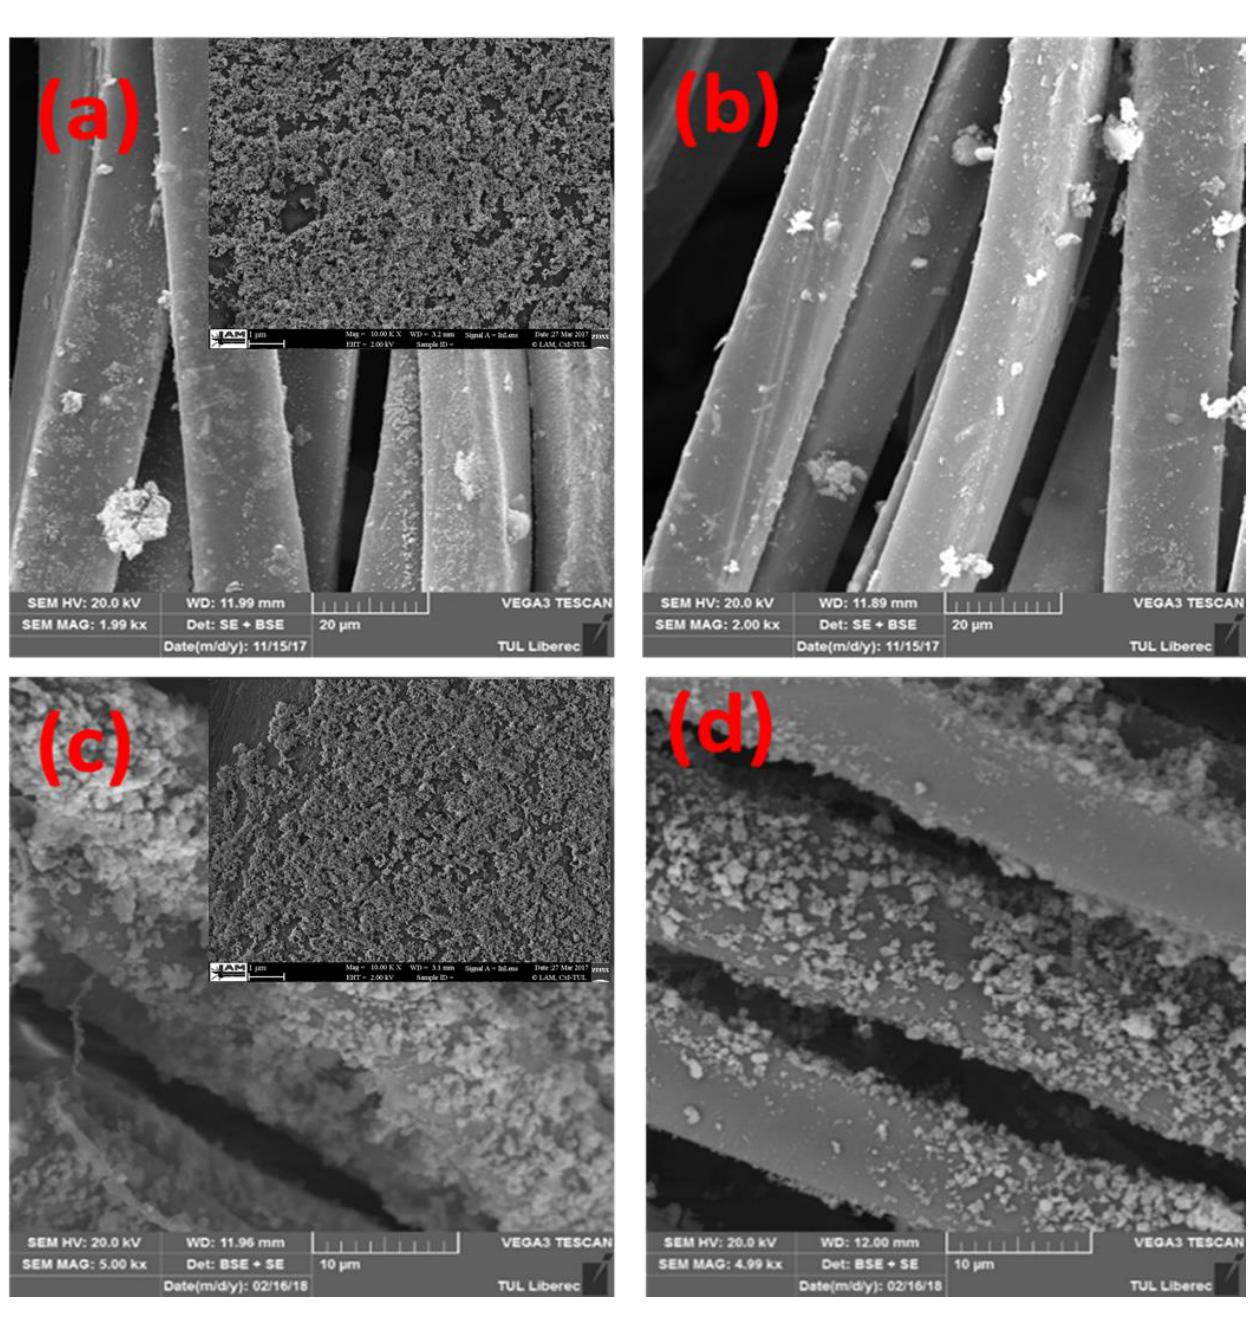
Figure 4. SEM images of silver coated fabrics for ( a ) 17 g/L ( b ) 34 g/L silver nitrate concentrations and copper coated fabrics for ( c ) 10 g/L ( d ) 20 g/L copper sulfate concentrations .